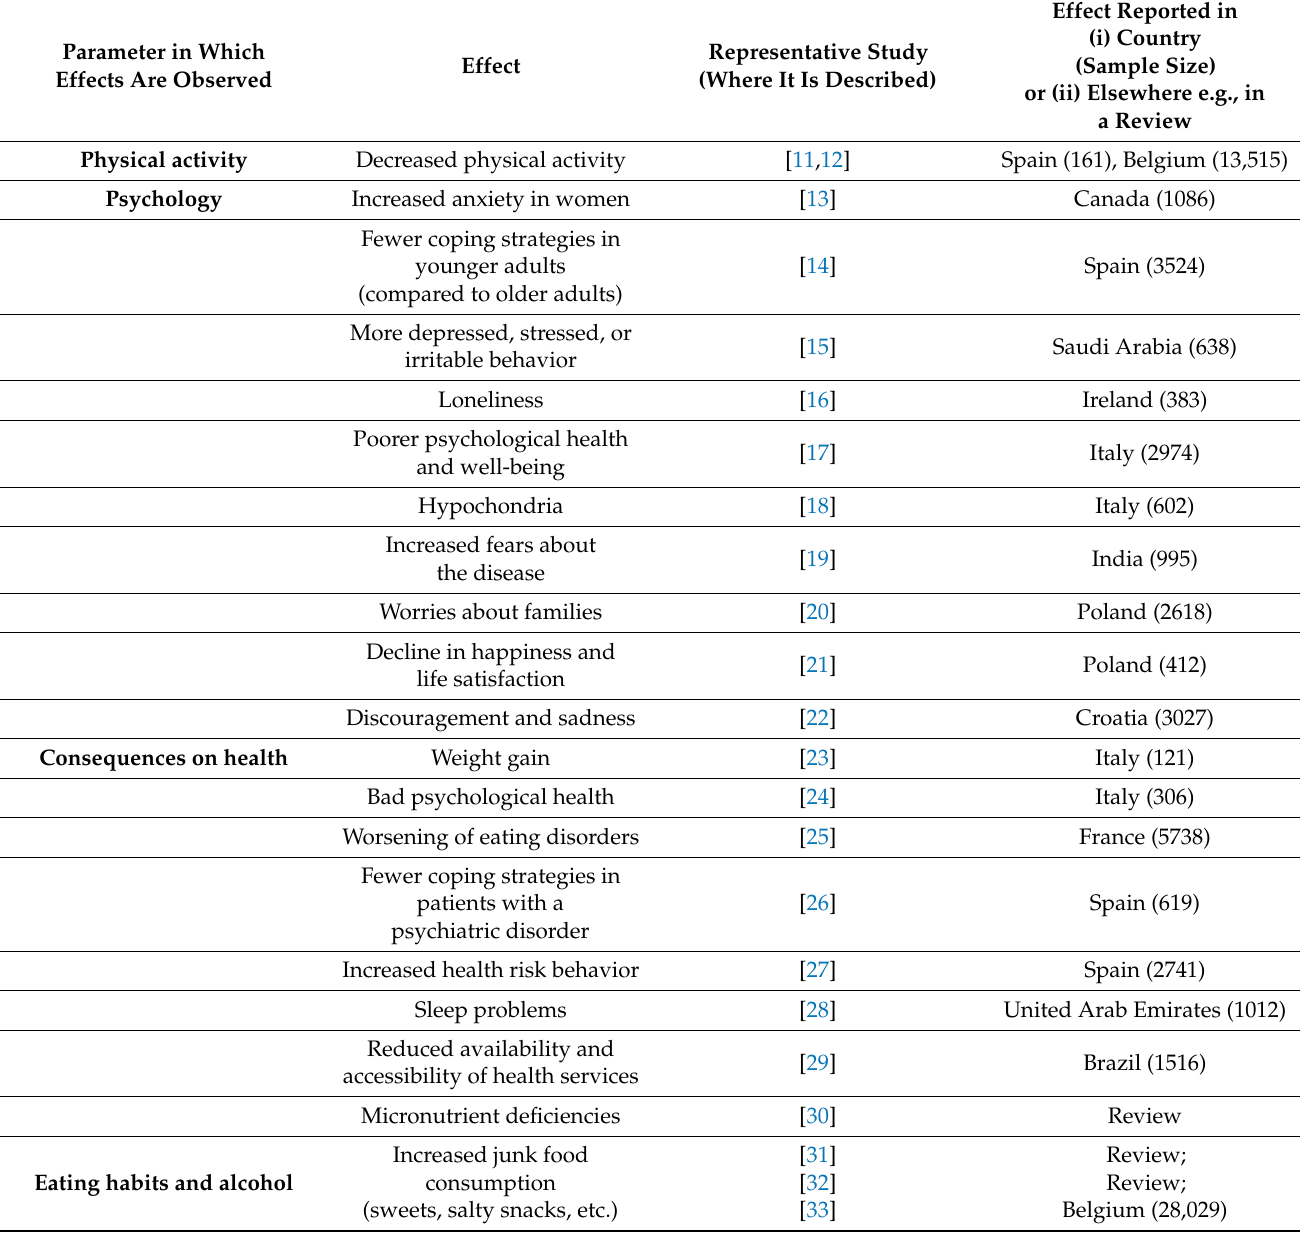
Table 1. Main effects due to